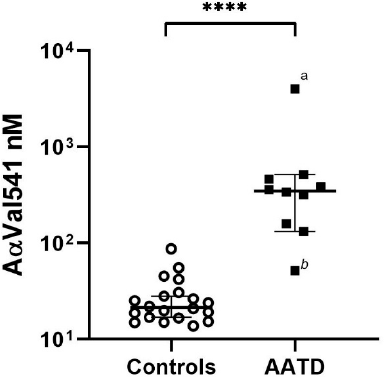
Figure 3. Higher levels of A α Val541 in AATD patients compared with healthy controls. The median (IQR) A α Val541 level in the AATD patients at the moment of assessment for eligibility for starting AAT augmentation therapy ( n = 10) was 348.3 nM (152.4–475.8 nM) and 21.4 nM (16.7–30.1 nM) in healthy controls ( n = 20). a represents an AATD patient with an FEV 1 of 17%predicted and KCO of 18%pred. b represents an AATD patient with an FEV 1 of 57%pred and KCO of 75%pred . ****, signif- icant difference p < 0.0001, Mann–Whitney U test.